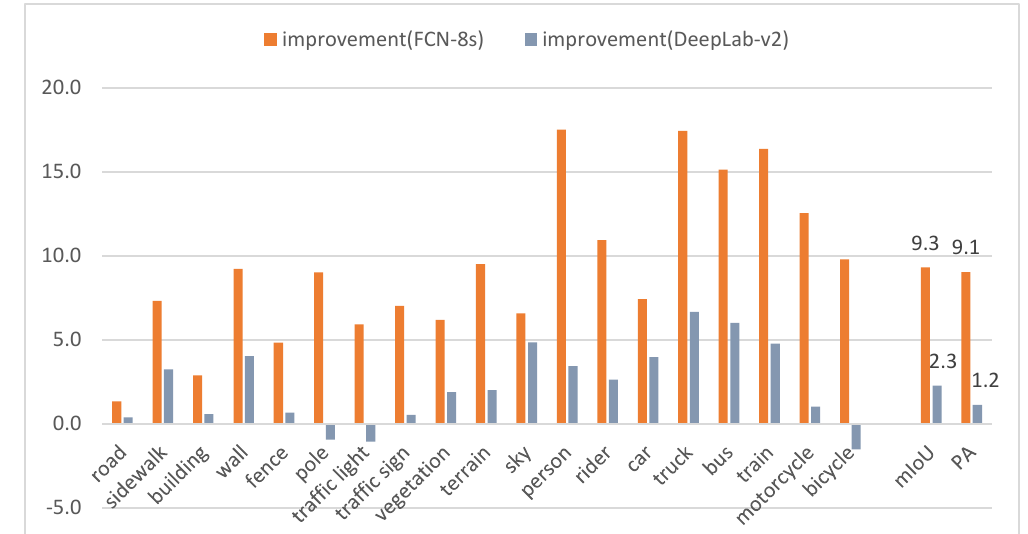
Figure 15. The improvement by our method compared with FCN-8s and DeepLab-v2.